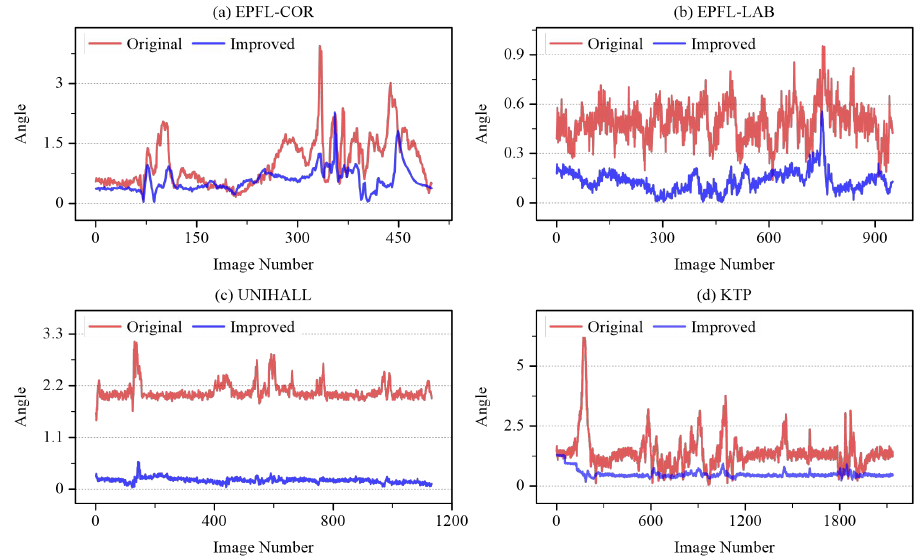
Figure 11. Comparison of the gravity direction estimation accuracy between our improved and original methods on four RGB-D